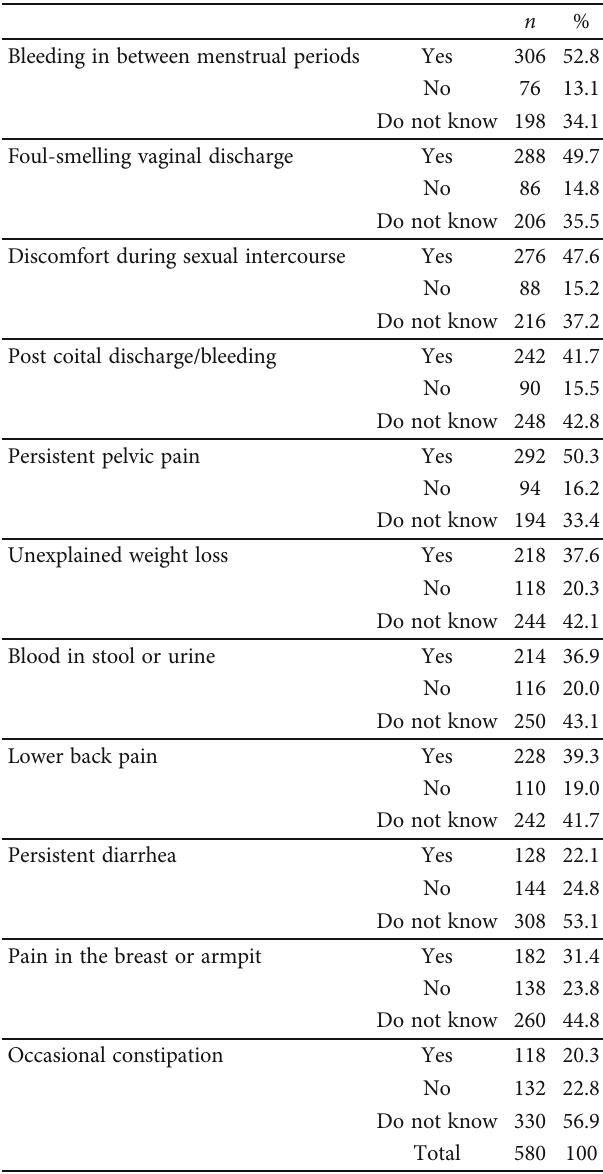
Table 3: Responses of the participants regarding the knowledge and awareness of the signs and symptoms of cervical cancer ( n = 580 ). n